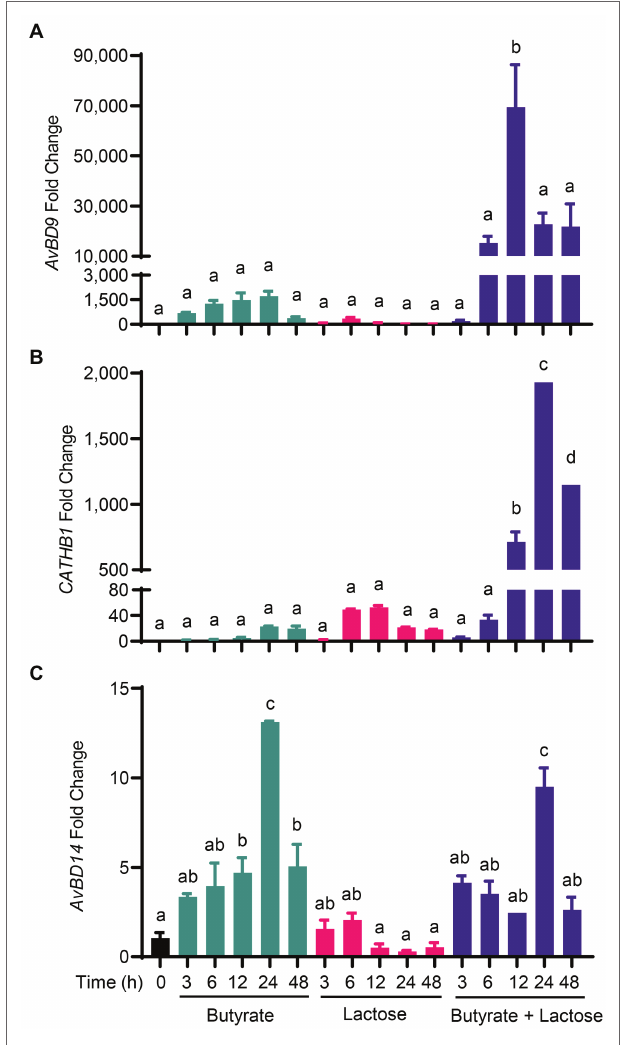
FIGURE 4 | Synergistic induction of HDP expression by butyrate and lactose. Chicken HD11 macrophage cells were stimulated in duplicate with 2 mM sodium butyrate and 0.2 M lactose individually or in combination for 3, 6, 12, 24, or 48 h, followed by RNA isolation and RT- qPCR analysis of the mRNA expression levels of AvBD9 (A) , CATHB1 (B) , and AvBD14 (C) . Results are expressed as means ± SEM of 2–3 independent experiments. The bars without common superscript letters denote statistical significance ( p < 0.05) as determined by one-way ANOVA and post hoc Tukey’s